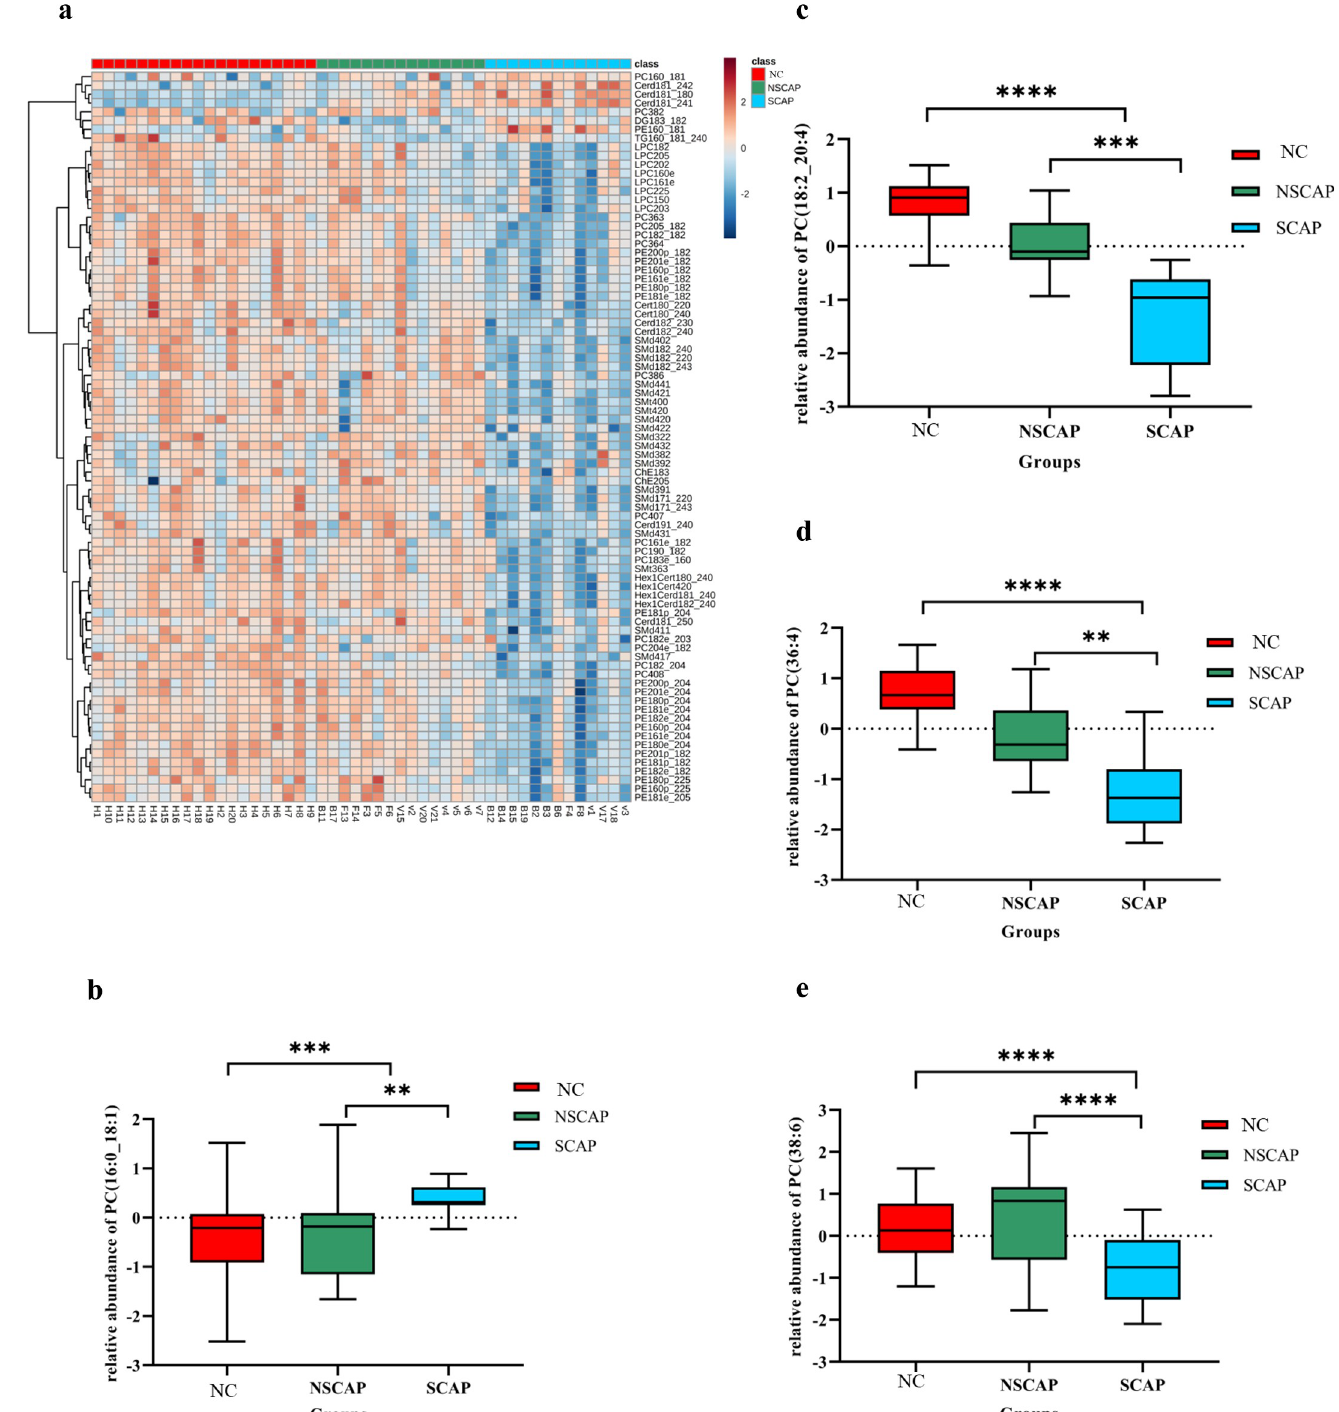
Fig 2. The relative abundance of different lipids changed in the three groups of samples. Red, green, and blue represent NC, NSCAP, and SCAP, respectively. (a) Hierarchical cluster heatmap of the relative abundance of 83 lipids in CAP (including NSCAP and SCAP) compared to NC. Distance measure: Pearson; Clustering algorithm: ward. Row represents lipids and column represents serum samples. Red, green, and blue represent NC, NSCAP, and SCAP, respectively. Light blue indicates lower relative abundance, while greater brown indicates higher intensity of lipids. (b-e) Changes in the relative abundance of PC (16:0_18:1), PC (18:2_20:4), PC (36:4) and PC (38:6) in serum between CAP group versus NC and NSCAP versus SCAP group. � p < 0.05, �� p < 0.01, ��� p < 0.001, ���� p < 0.0001.